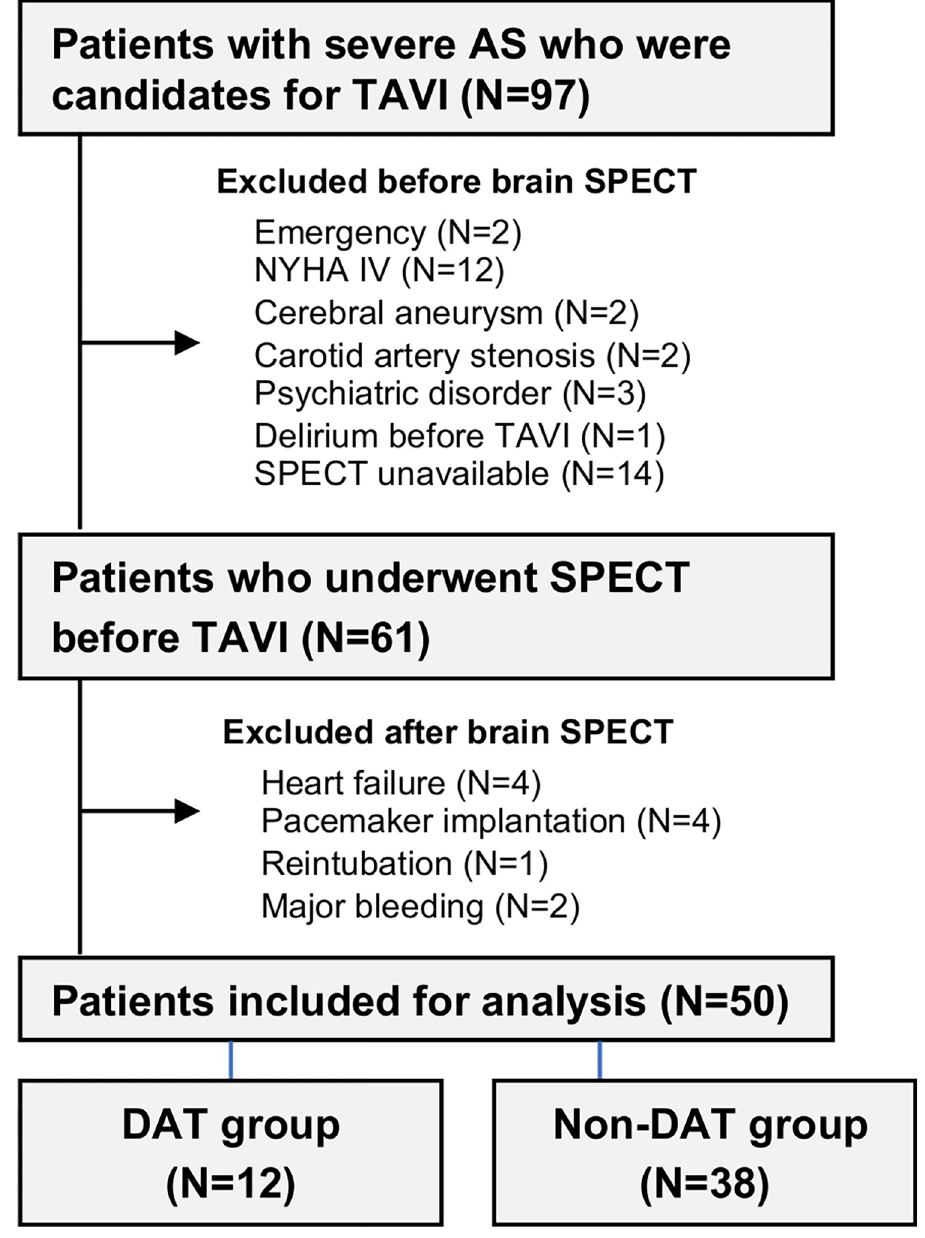
Fig 1. Flow chart of patient enrollment in the present study. Abbreviations: AS, aortic stenosis; DAT, delirium after TAVI; NYHA, New York Heart Association; SPECT, single-photon emission computed tomography; TAVI, transcatheter aortic valve